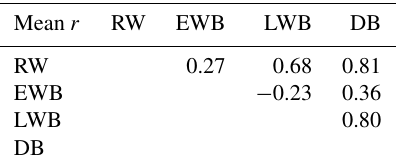
Table 3. Correlation matrix between the different tree-ring variable chronologies (200-year spline detrended). These values represent the averages for between TR variable correlations performed sepa- rately for each